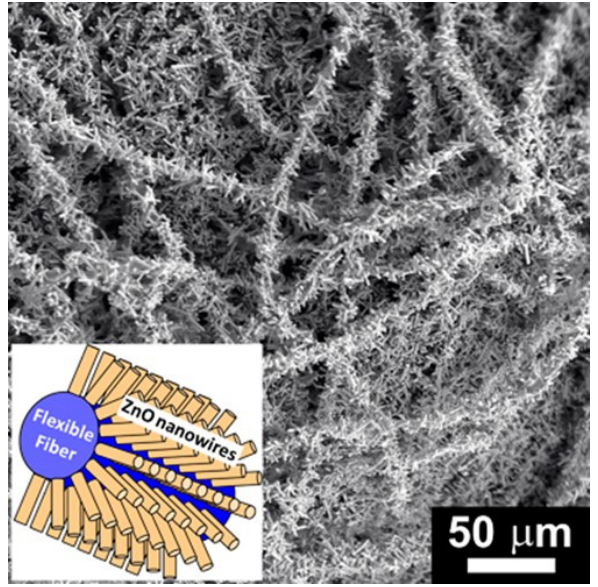
Figure 9. Hierarchical fibrous polymer/ZnO nanostructures. Low-magnification SEM image of the hierarchical nanostructure consisting of radially aligned ZnO nanowires grown on electrospun poly-L-lactide nanofibers. Inset: schematic representation of the hierarchical nanostructure. (Reprinted from the work of Sugunan et al. [36]. Copyright 2021, with permission from John Wiley and Sons).